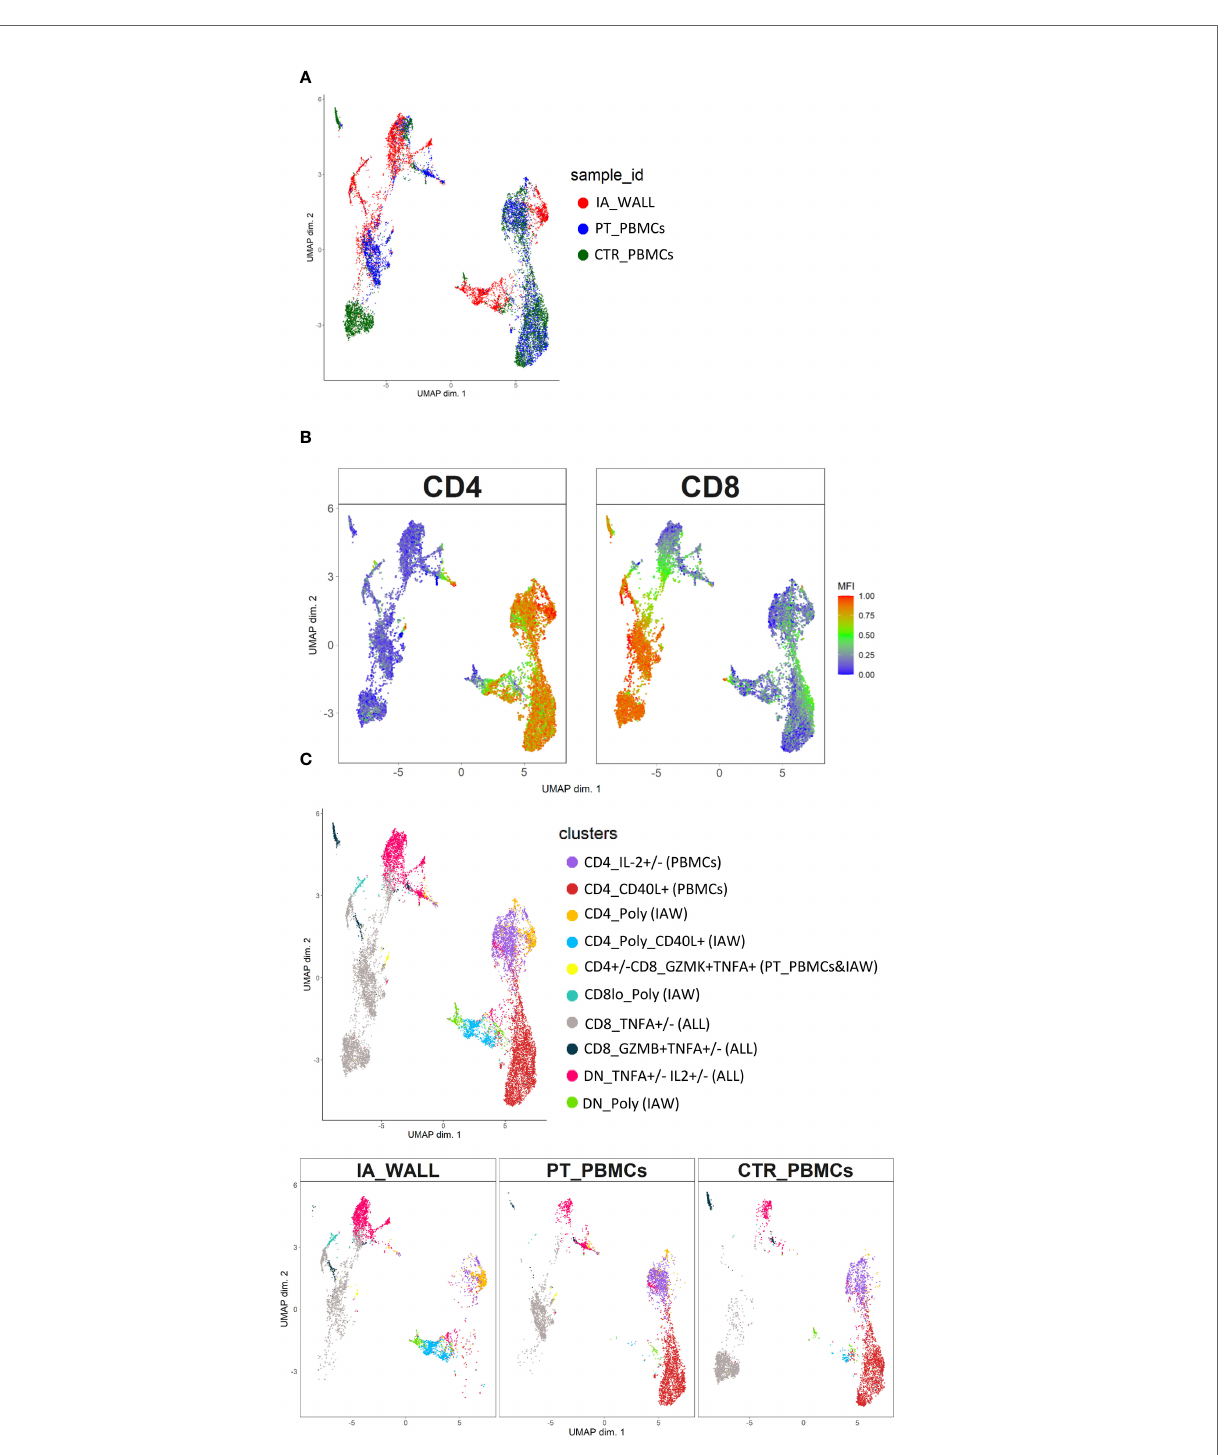
FIGURE 5 | Unsupervised analysis of cytokine producing capacities identi fi es polyfunctional T-cell clusters in the IA wall. (A) UMAP obtained using normalized expression of intracellular cytokines and selected differentiation markers, colored according to the analysed sample (i.e. red: IA_WALL, blue: PT_PBMCs and green: CTR_PBMCs). (B) UMAP of CD4 and CD8 expression. Blue denotes low, green intermediate and red high expression. (C) UMAP analysis identi fi ed ten clusters that were either largely unique for the IA_WALL or for peripheral blood (PBMCs), but also some that were common to all samples ( “ ALL ” ). Clusters were colored according to cytokine expression as indicated, the sample of origin is indicated in parenthesis. Clusters that were positive for at least 3 different cytokines were named polyfunctional ( “ POLY ” ). The upper UMAP plot shows an overlay of all three samples. The lower UMAP Plots were strati fi ed according to sample of origin: “ IA_WALL ” , “ PT_PBMCs ” and “ CTR_PBMCs ”